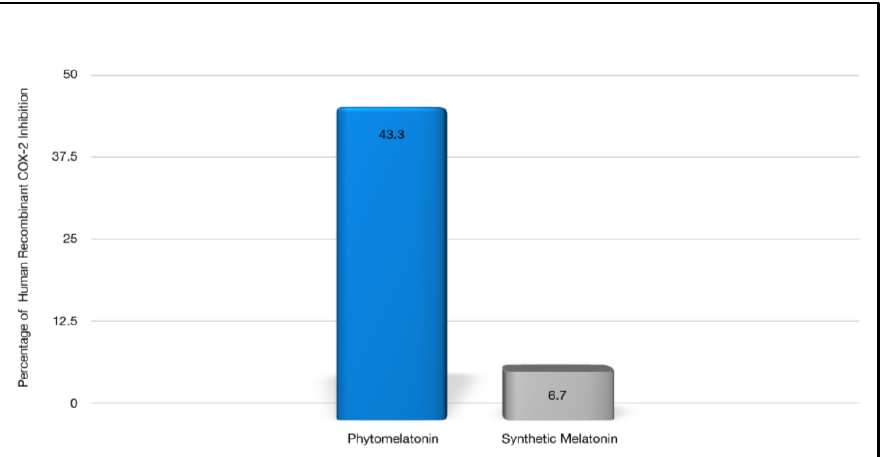
Figure 3. Inhibition of inflammation by phytomelatonin (blue bar) and synthetic melatonin (gray bar). Data are expressed as a percentage of human recombinant COX-2 inhibition. Amounts used for each were 0.030 mL (5 mg/mL). Values are derived from the original data presented in [34].